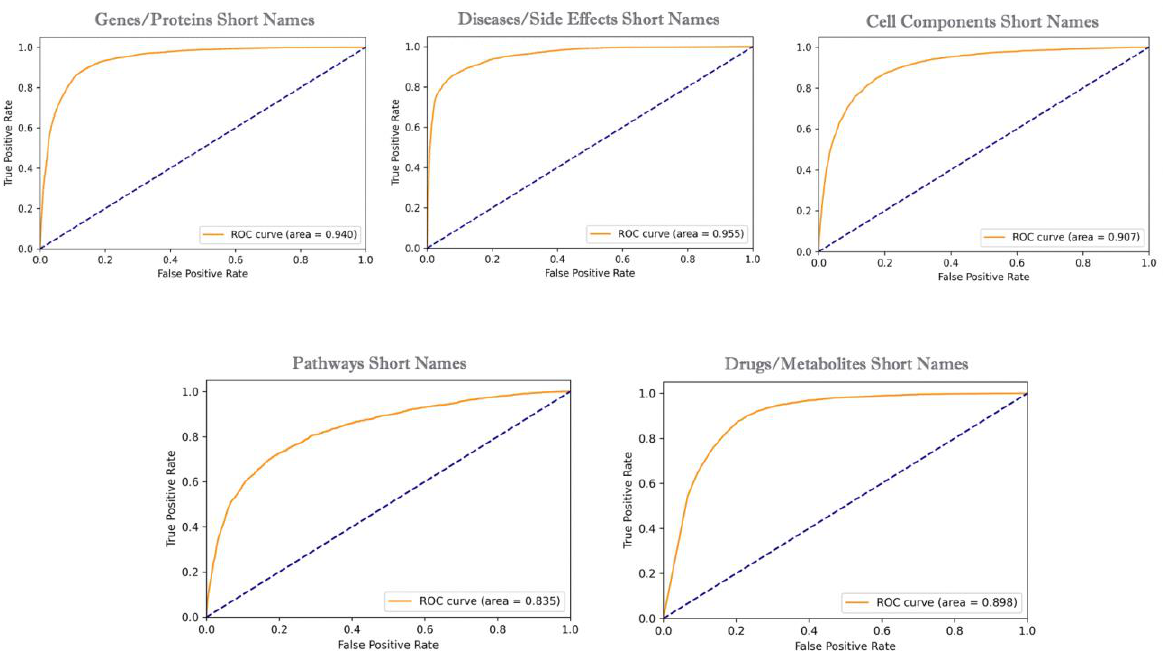
Figure 3. ROC curves illustrate short names’ classification accuracy of the fine -tuned models for different object types. Genes/proteins (area under the ROC curve (AUC) = 94.0%). Diseases/side effects (AUC = 95.5%). Cell components (AUC = 90.7%). Cellular pathways (AUC = 83.5%). Drugs/metabolites (AUC = 89.8%). Table 1. TPR, FPR, and optimal thresholds for each classification